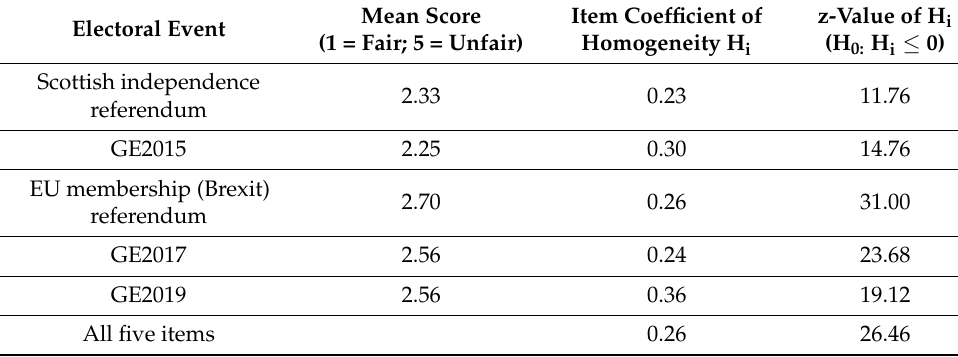
Table A2. Mokken scale analysis of responses to expected electoral fairness items.